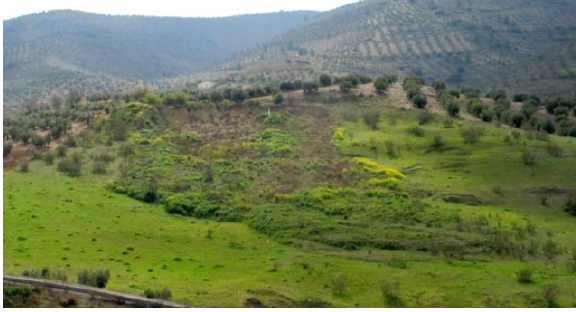
Figura 2. Studied landslide.